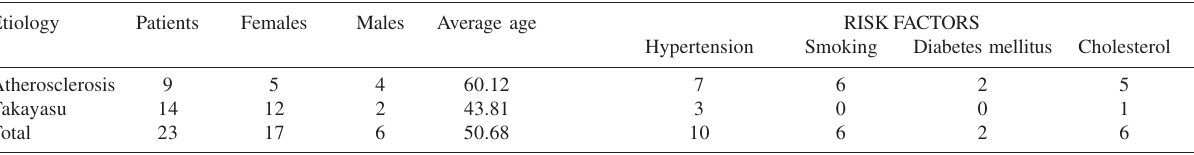
Table 2 - Subclavian artery occlusive disease group - Patients’